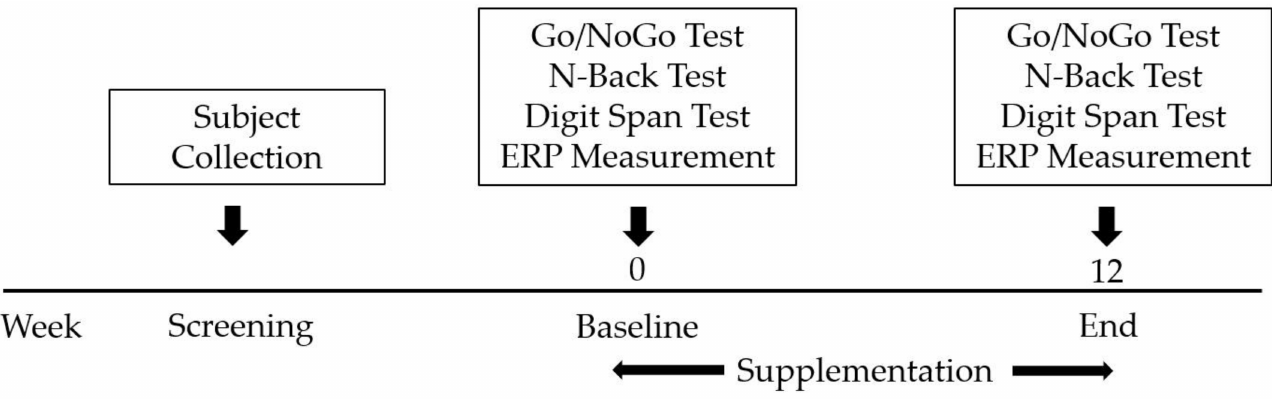
Figure 2. The timeline of cognitive battery task performance and event-related potential (ERP)